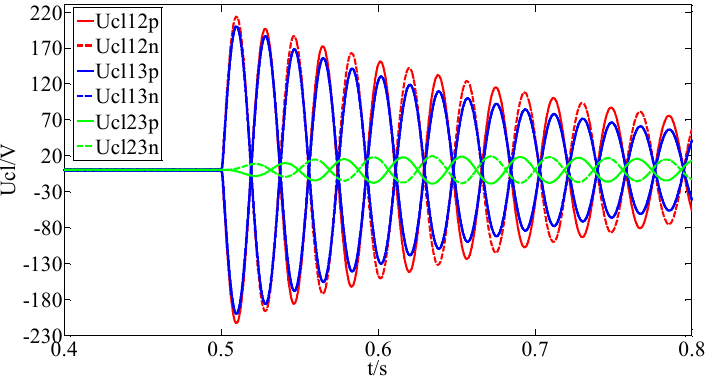
Figure 17. Voltage waveforms of the CLIs with power reversal.